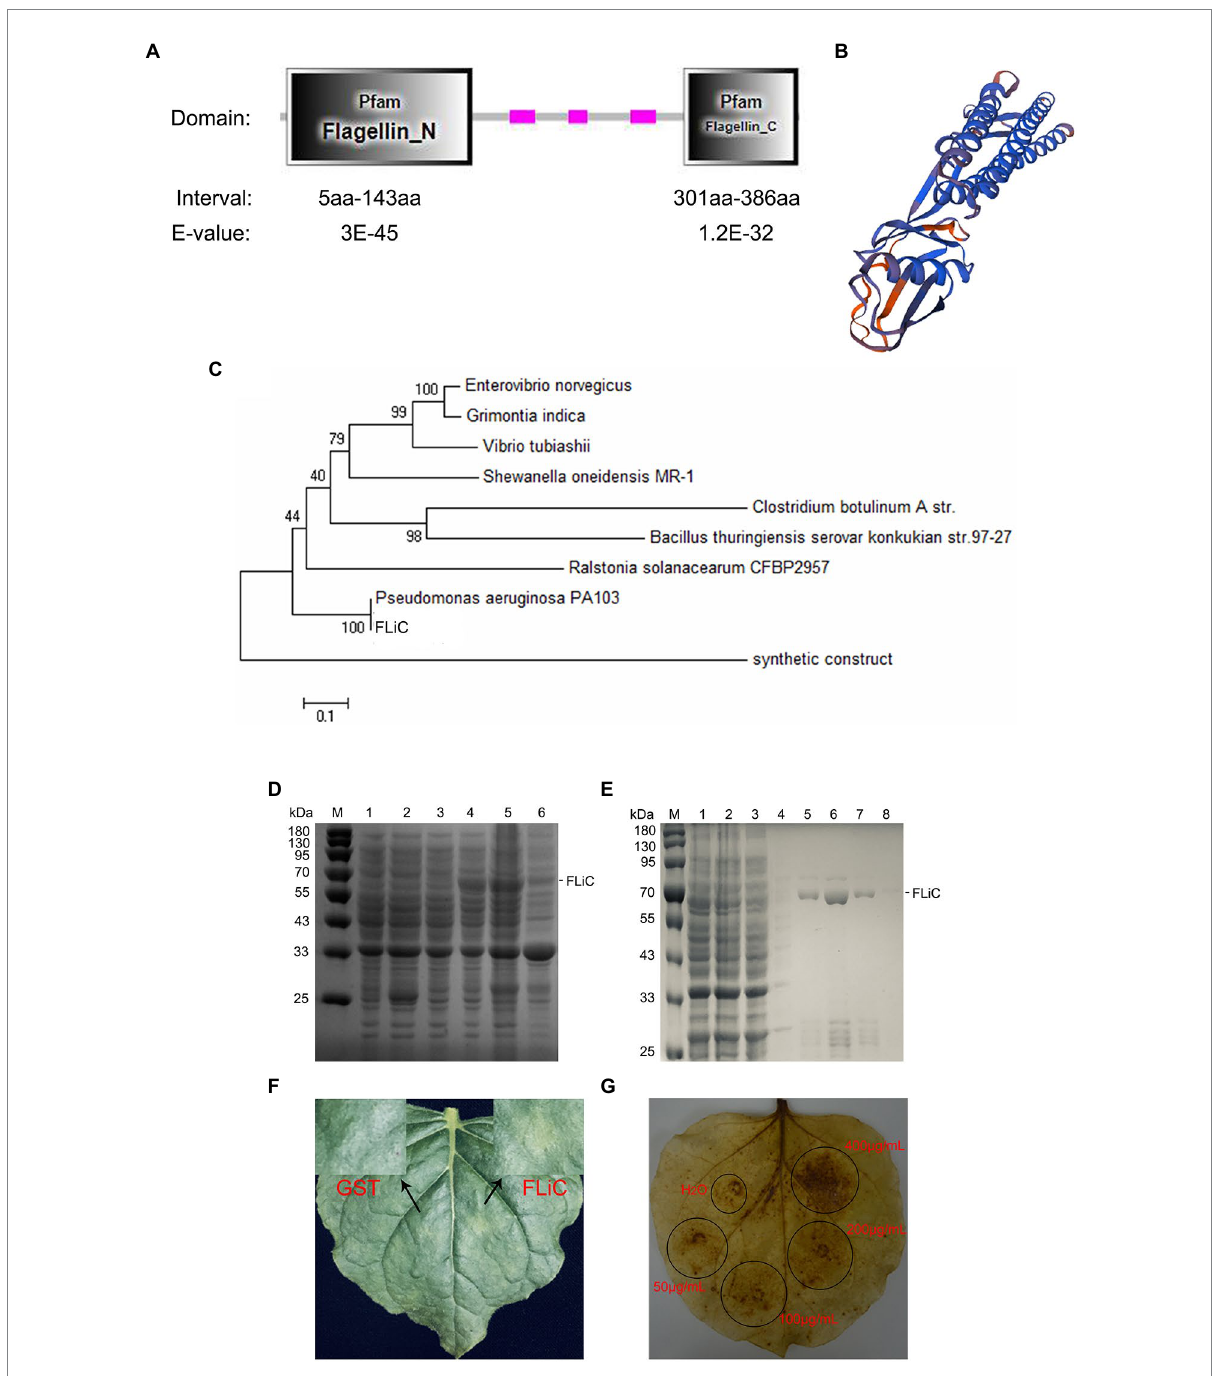
FIGURE 1 Structure and hypersensitive response (HR) of flagellin C (FLiC). (A) Two functional domains of FLiC protein. (B) Three-dimensional structure diagram of FLiC protein. (C) Evolutionary tree of FLiC proteins. (D) Expression of FLiC recombinant protein in Escherichia coli at 28 ° C [M protein marker; (1) control containing an empty vector; (2) control containing an empty vector with addition of an inducer (0.5 mM IPTG); (3) whole bacteria with addition of an inducer (0 mM IPTG); (4) whole bacteria with addition of an inducer (0.5 mM IPTG); (5) supernatant after the bacterial cells were sheared; (6) pellet after the bacterial cells were sheared]. (E) Purified FLiC protein (M protein marker; 1, cell lysate; 2, flow-through; 3, wash 1; 4, wash 2; 5, elution 1; 6, elution 2; 7, elution 3; and 8, elution 4). (F) HR of tobacco treated with FLiC. The concentration of FLiC protein was 100 μ g/ml; the photograph shows the backside of tobacco 24 h after injection. (G) Hydrogen peroxide (H 2 O 2 ) generated after treatment with FLiC protein solutions at different concentrations. Diaminobenzidine (DAB) staining was used to visualize H 2 O 2